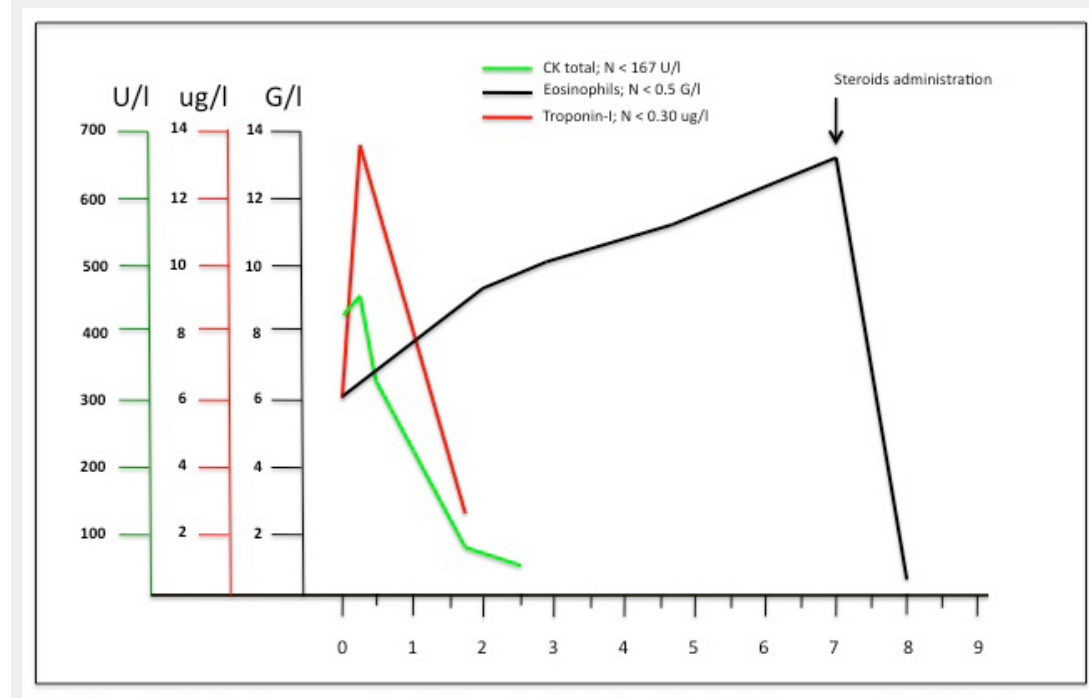
Representation of cardiac enzymes and eosinophils count evolution between the arrive in the emergency unit and the day after corticosteroid